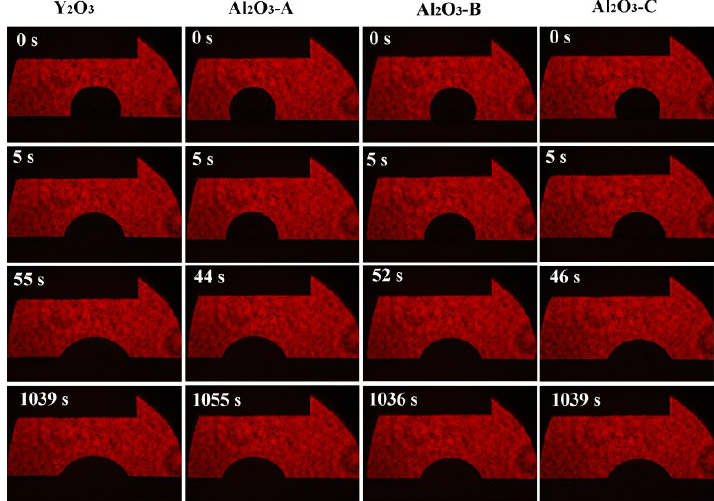
Figure 8. Wetting process of the Ti-47Al-2Cr-2Nb alloys on substrates with various compositions at 1873 K.